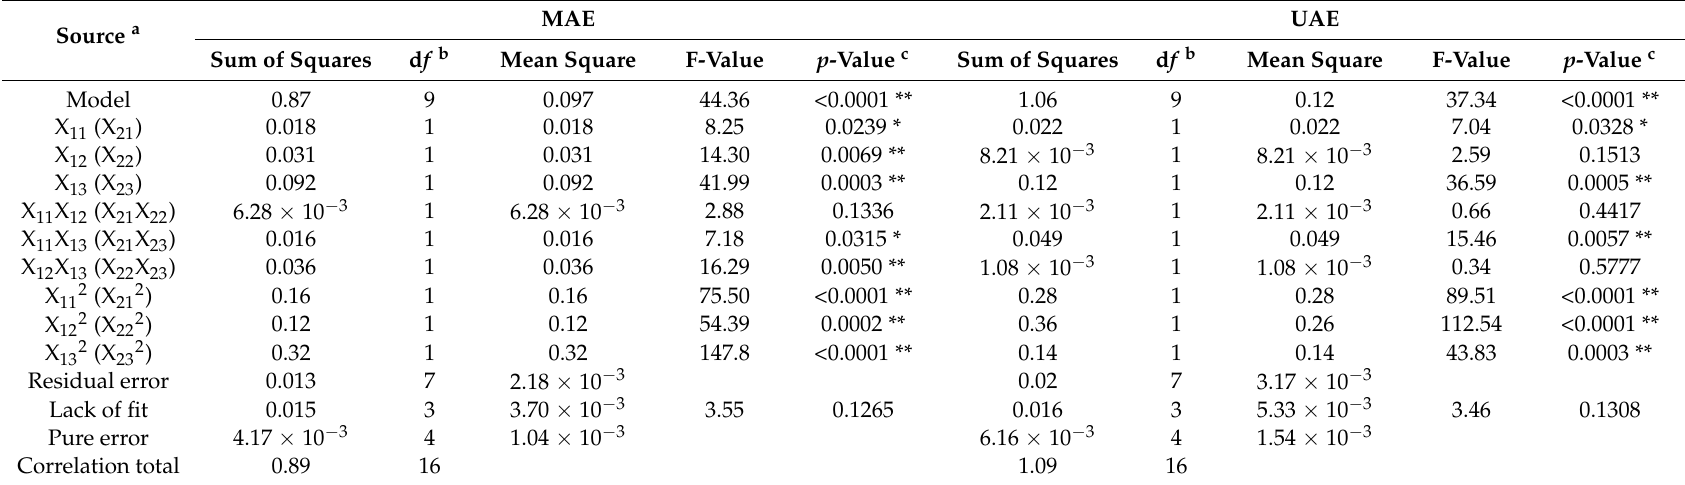
Residual error 0.013 Lack of fit Correlation